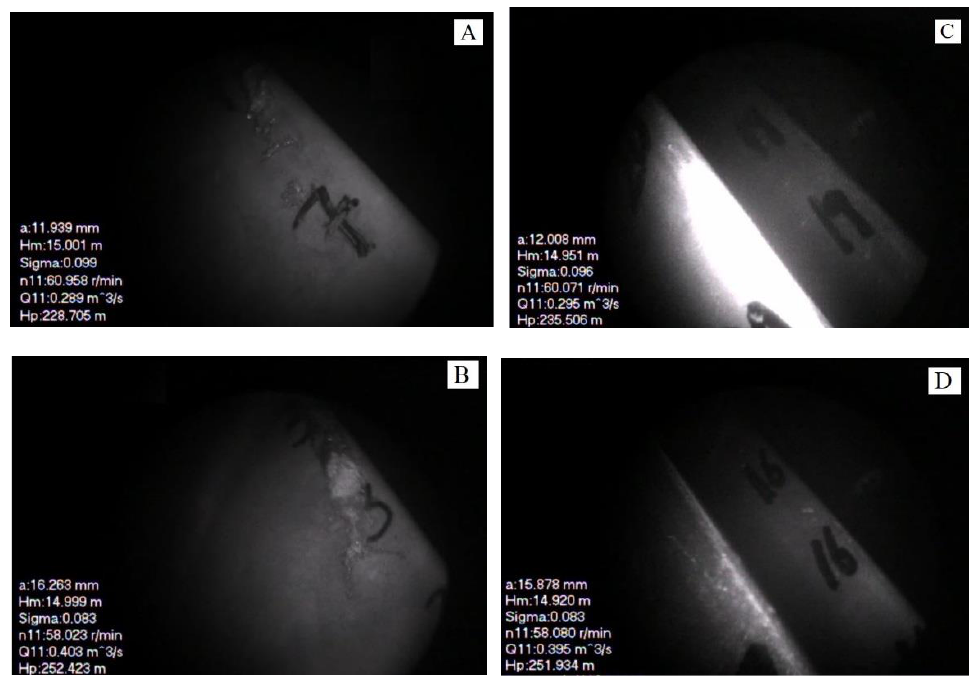
Figure 10. Flow pattern observation at four operating points (A, B, C, and D).